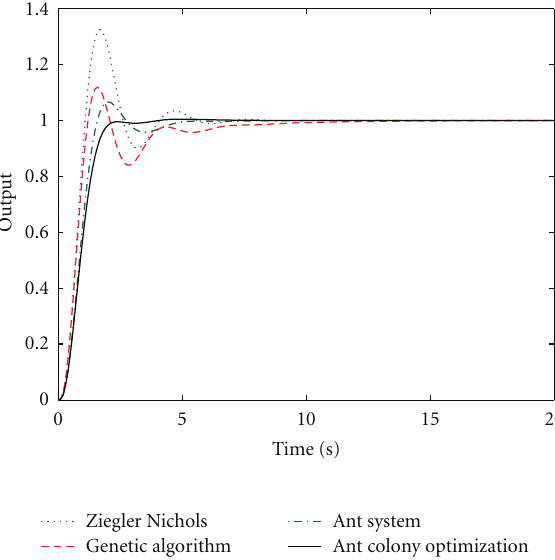
Figure 6: Comparison of step responses of the G 2 ( s ) plant.